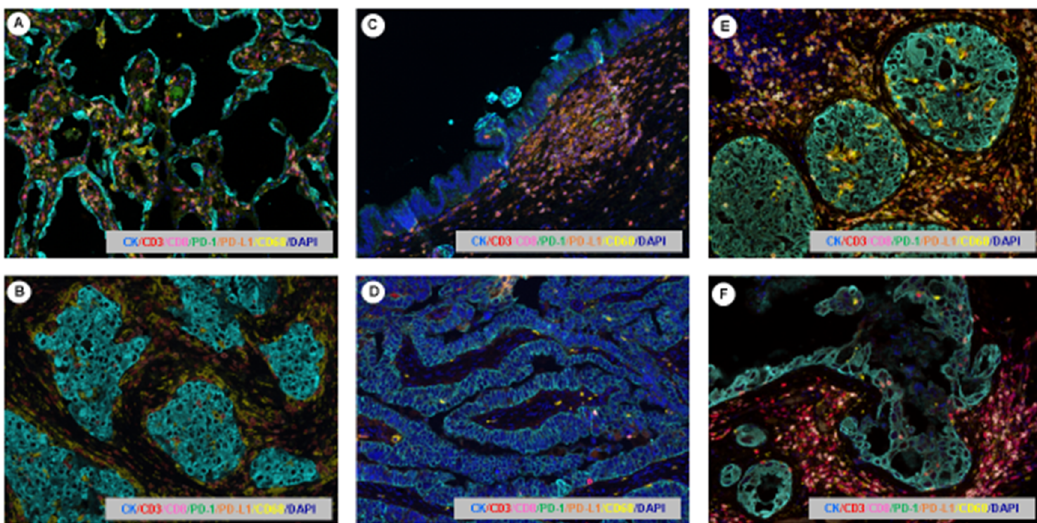
Figure 5. Multiplex immunofluorescence microphotography. Images representing the immunoprofiling of different stages of progression in lung, pancreas and breast cancer using the multiplexed tyramine signal amplification system: ( A ) pre-neoplastic lung lesion, ( B ) lung adenocarcinoma, ( C ) pre-neoplastic pancreatic lesion, ( D ) invasive pancreatic carcinoma, ( E ) non-invasive breast carcinoma, ( F ) invasive breast carcinoma. Scale bar: 200 ×